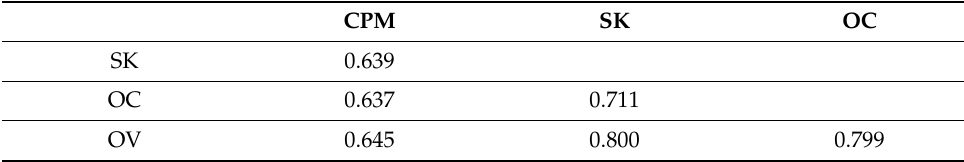
Table 4. Discriminant validity (heterotrait–monotrait ratio, HTMT).